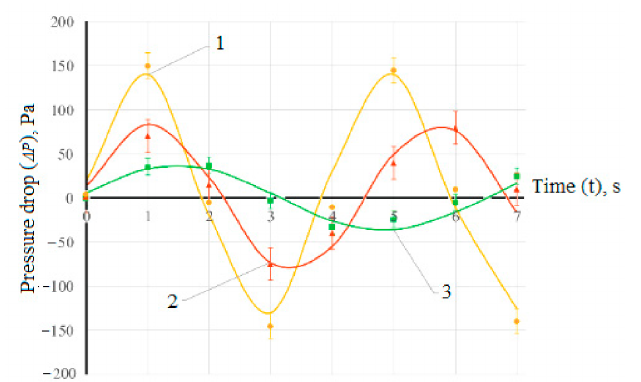
Figure 5. Dependence of the pressure drop ( ∆ p ) in the dust respirator on time ( t ) when performing easy work (1), medium physical activity (2) and hard work